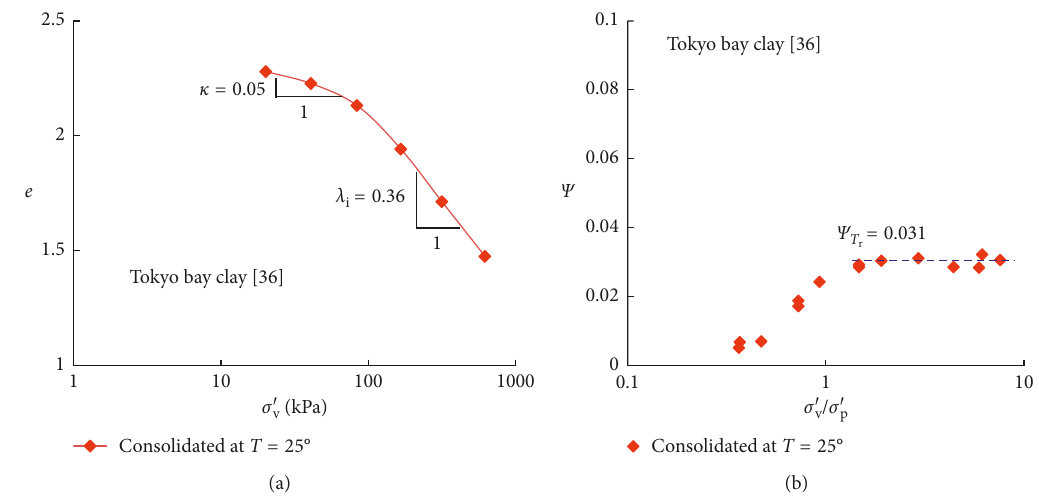
Figure 10: Determination of parameters from the oedometer tests for the sample consolidated at room temperature: (a) compression curves; (b) creep coefficient versus vertical stress.